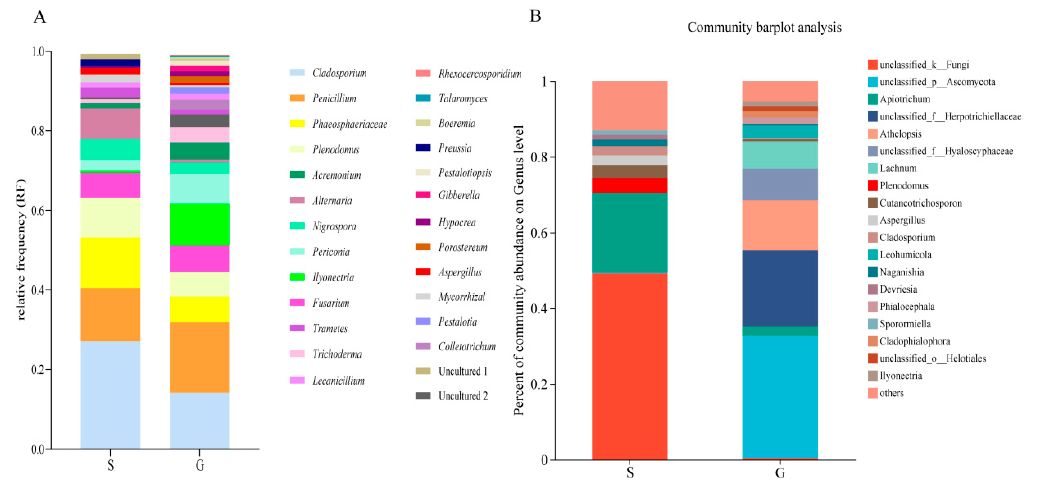
Figure 2. The relative abundance of endophytic fungi of S. chamaejasme at genus level. ( A ): culture- dependent endophytic fungi; ( B ): culture-independent endophytic fungi. The fungi with a relative abundance below 0.1% were grouped as ‘others’. S = Shoot; G = Root.